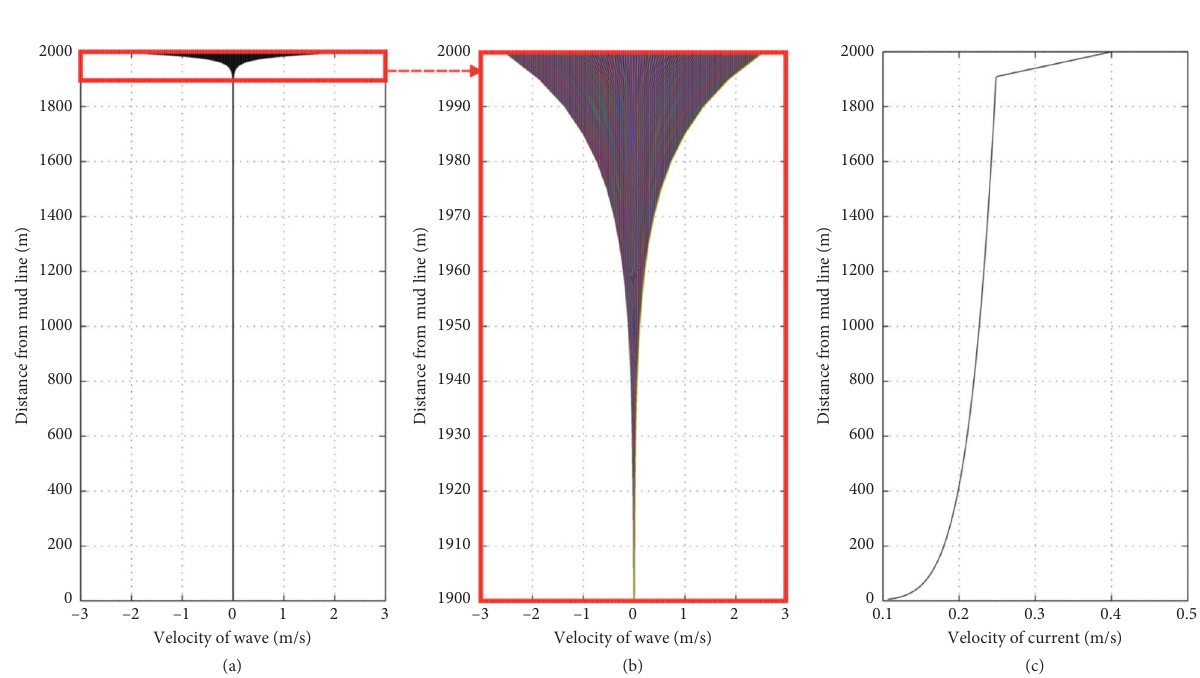
Figure 3: Ocean environmental loads, (a) distribution of wave velocity, (b) enlarged view of the wave velocity distribution close to the ocean surface, (c) distribution of sea current